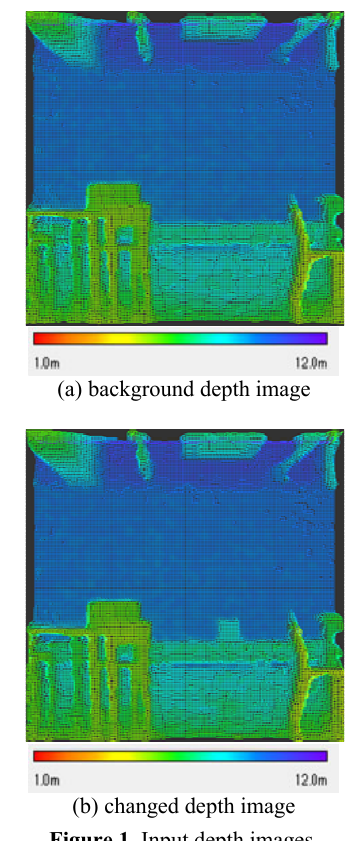
Figure 1 . Input depth